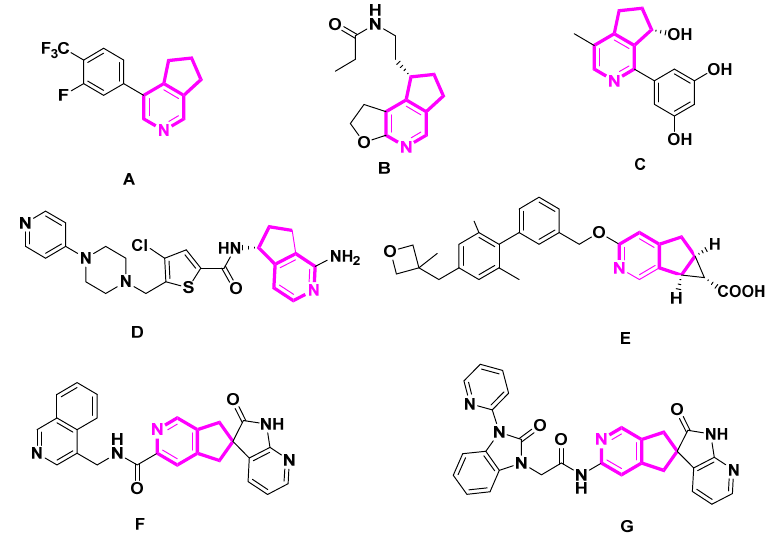
Figure 1. Examples of bioactive cyclopenta[c]pyridine derivatives.